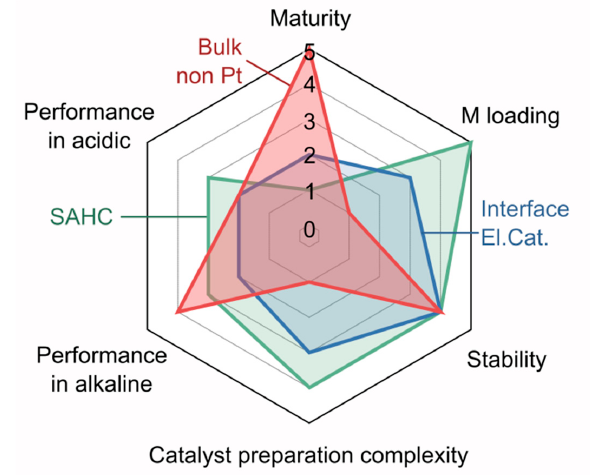
Figure 9. Comparison of the analyzed groups of electrocatalytic systems presented in this review (Authors’ view). We consider maturity, metal loading (M loading), stability (under operating conditions), the complexity of the catalyst preparation, the overall performance in alkaline solutions, and the overall performance in acidic solutions. Note that in the case of the catalyst preparation complexity case, higher grade means more complex preparation.